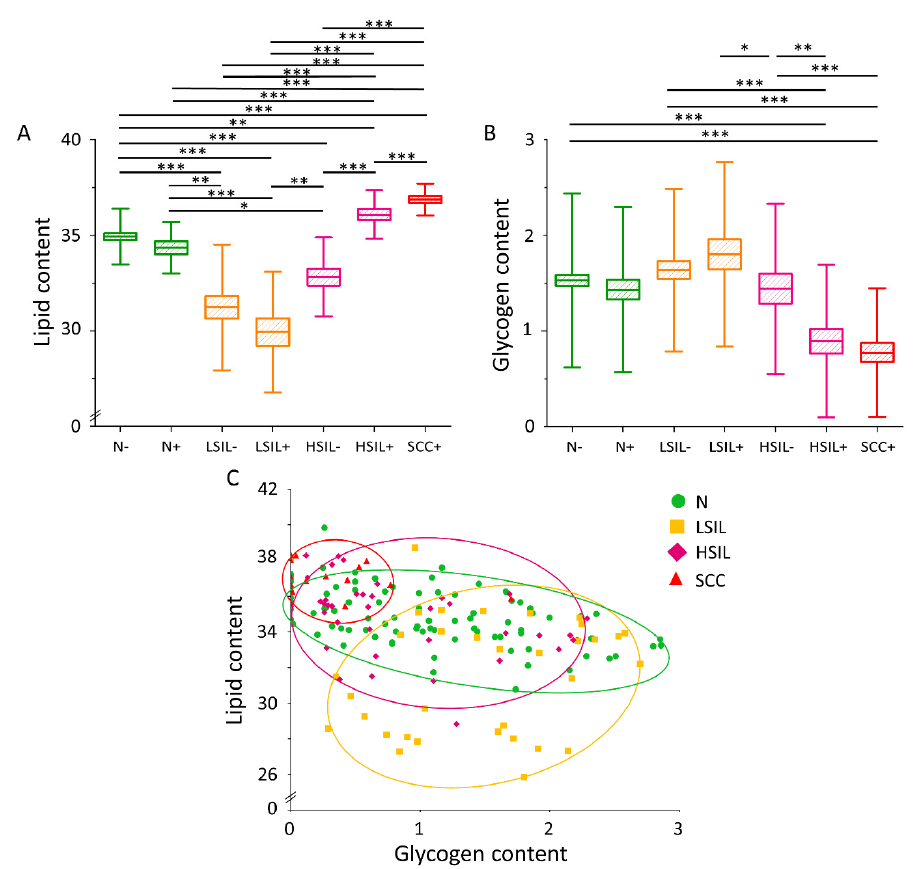
Figure 2. Lipid and glycogen contents in the cytoplasm of cervical epithelial cells depending on the degree of dysplasia and HPVhr infection. The comparison of the lipid ( A ) and glycogen ( B ) content in the cytoplasm of cervical epithelial cells in the studied groups obtained by calculations of the integral intensity in the 2830–3000 cm − 1 and 458–482 cm − 1 range, respectively. Mean values ± SEM are given as box plots: mean (horizontal line), SEM (box), SD (whiskers). Lipid content as a function of glycogen content in the cytoplasm of cervical epithelial cells ( C ) The average lipid and glycogen contents obtained by calculations of the integral intensity of the marker bands in the 2830–3000 cm − 1 and 458–482 cm − 1 range, re- spectively) in the studied groups. Each mark represents data for one cell. A significant correlation was obtained for the N ( p < 0.001) and HSIL ( p < 0.01) groups. * p < 0.05, ** p < 0.01, *** p < 0.001. Levels Confirming Increased Inflammation in the LSIL Group The level of lipid unsaturation in LDs of cervical epithelial cells was obtained based on Raman data. Lipid unsaturation is the highest in the LSIL group and the lowest for cancer cells (SCC group, Figure 3A). Complete statistical data on the lipid unsaturation in LDs have been included in the Supplementary Materials (Table S5). Previously increased lipid unsaturation was directly related to inflammation due to activation of the arachi- donic cycle [47,48].